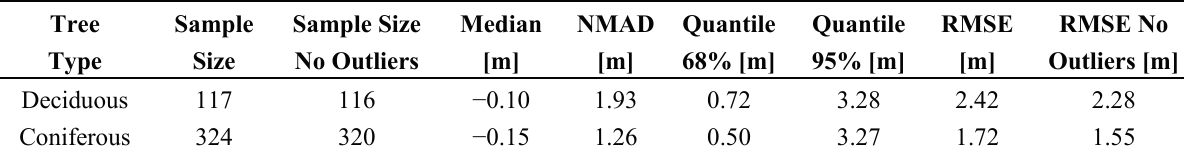
Table A5. Comparison of double measurements of the heights of 441 trees within the Swiss NFI to estimate measurement error. A threshold value of ±3 × RMSE was applied for outlier exclusion.